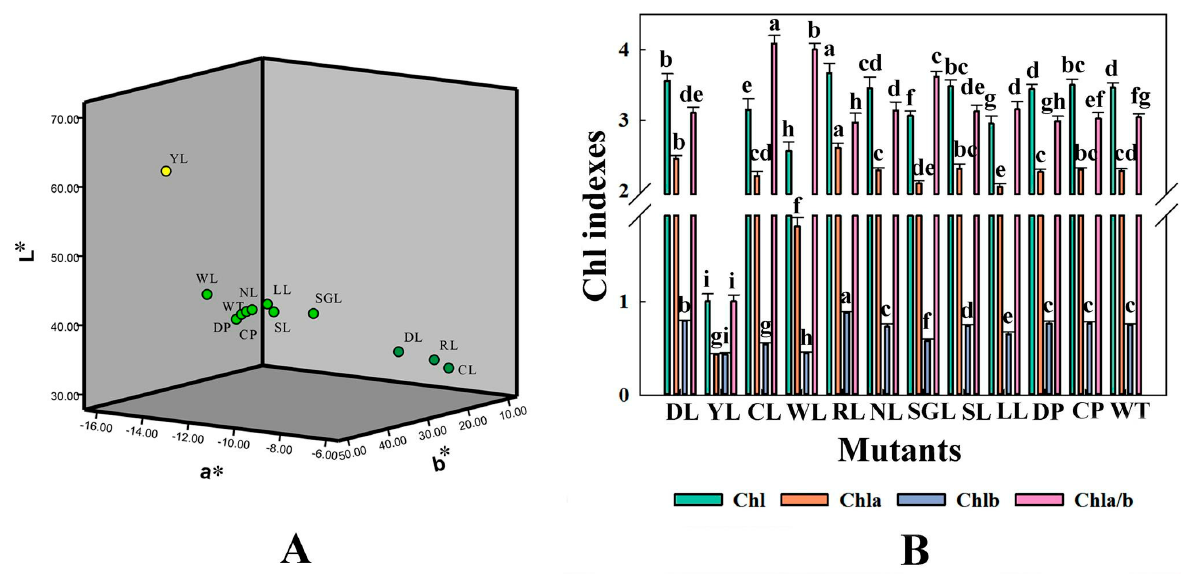
Figure 6. L *, a *, and b * values and chlorophyll content of 11 mutants in F. nilgerrensis . ( A ) Scatter plot of L *, a *, and b *; ( B ) contents of Chl, Chla, and Chlb and the ratio of Chla/b. Bars indicate S.E. of means, and different lowercase letters indicate significant differences between treatments according to LSD test ( p < 0.05) in Figure 6 B.